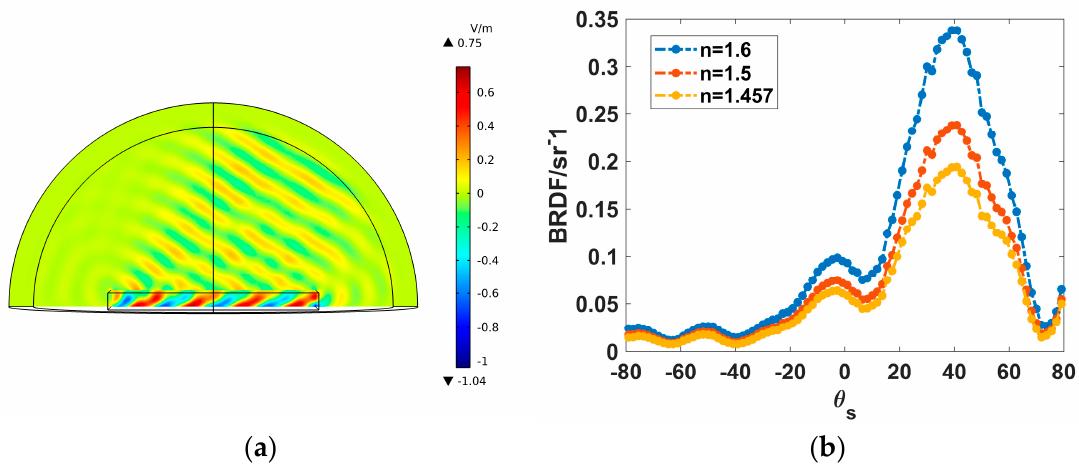
Figure 6. ( a ) Spatial distribution of scattered electric field intensity; ( b ) BRDF distribution curve of di ff erent refractive index.